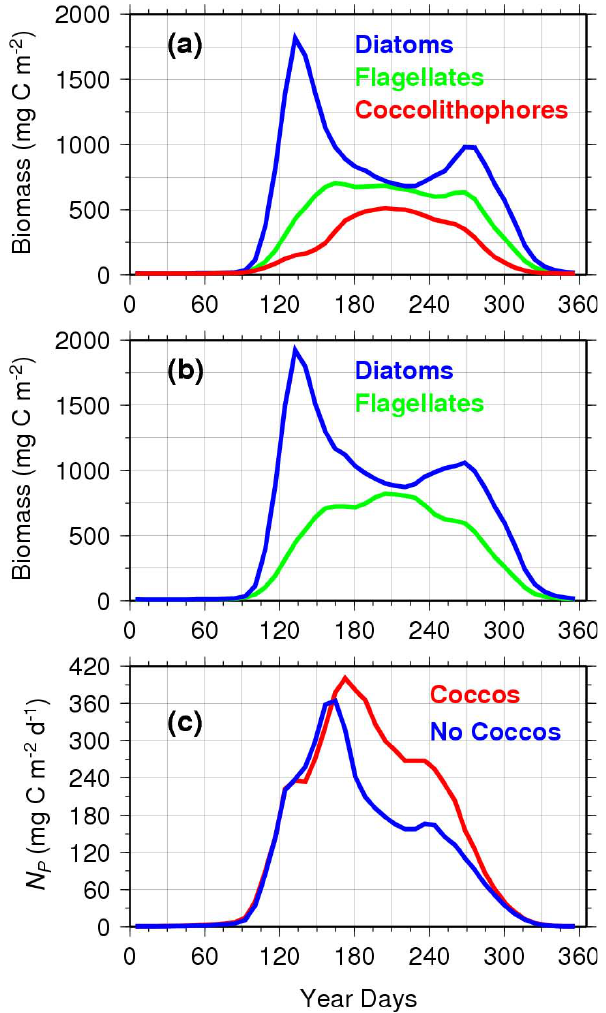
Fig. 13. Seasonal concentration of phytoplankton functional groups biomass with and without the presence of coccolithophores ( a and b , respectively), and net community production with and without coccolithophores (c)